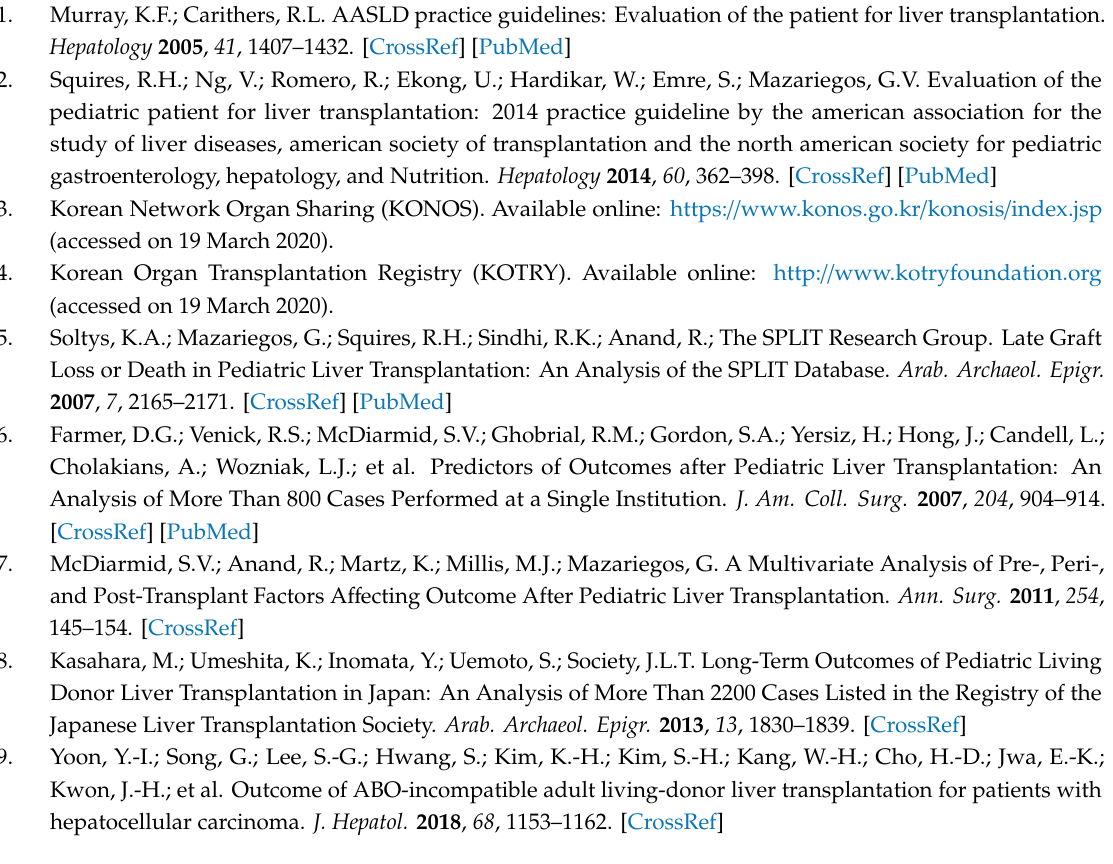
Figure S1: Kaplan–Meier analysis of overall survival using the KONOS database according to (A) waiting time, (B) type of LT. Table S1: Initial postoperative